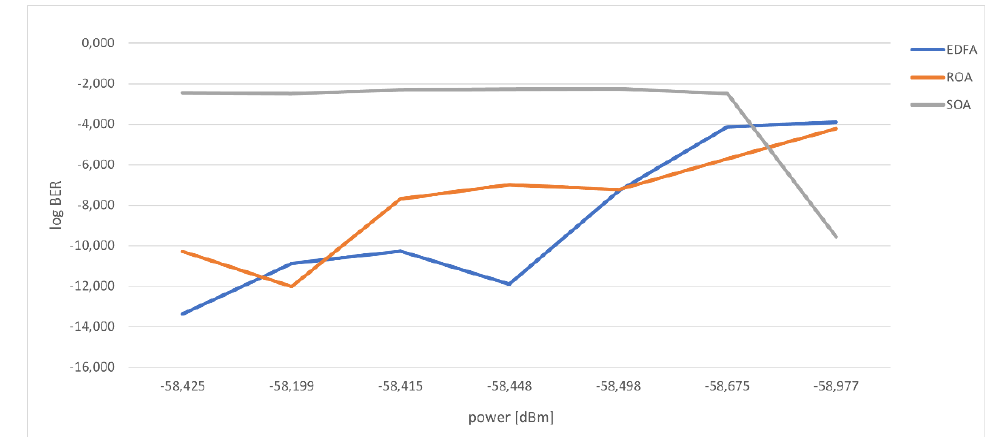
Figure 11. Amplifier comparison output power vs log of BER.